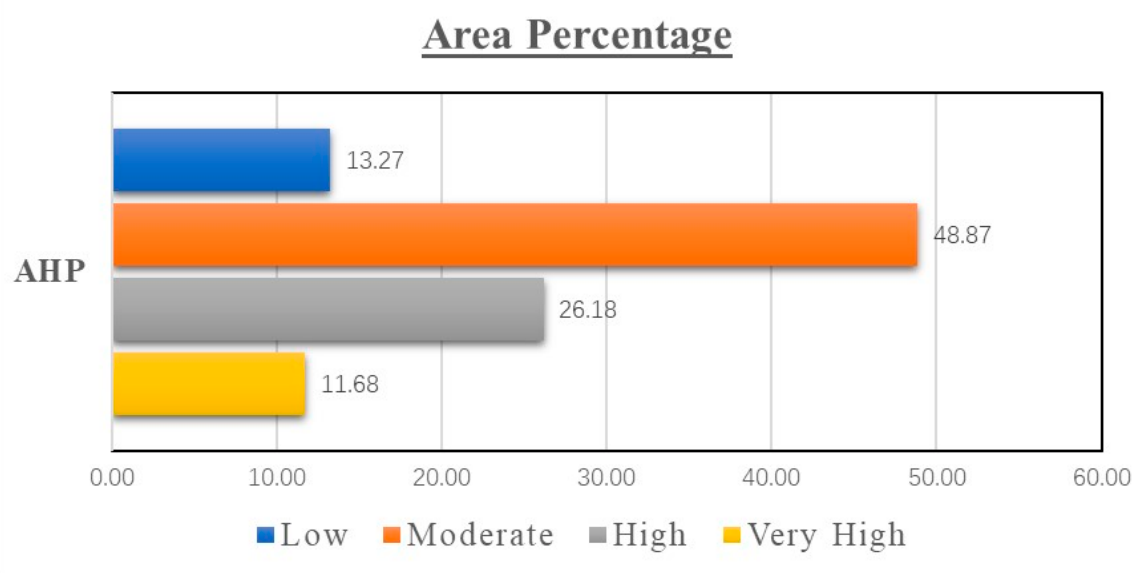
Figure 9. The graph shows the area percentage of di ff erent landslide susceptibility classes.